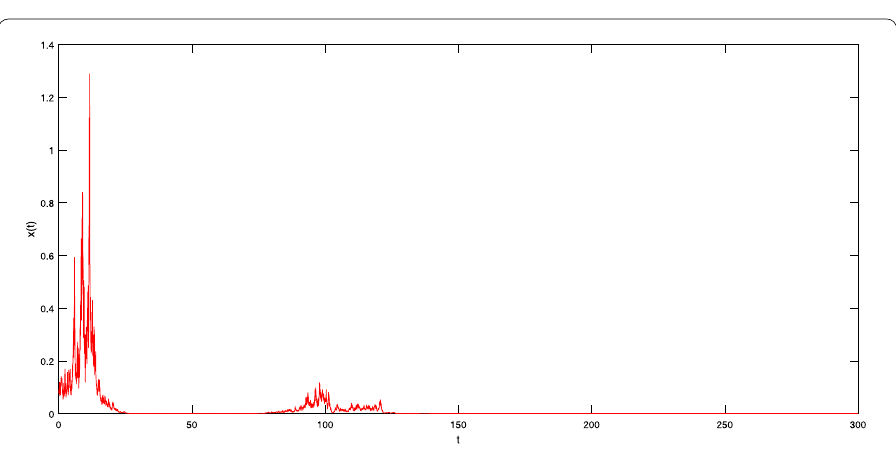
Figure 4 Solution of system (2) with σ 1 = 0.8, σ 2 = 0.2, σ 3 = 0.2, σ 4 = 0.6, σ 5 = 0.6, u = 0.3, γ =